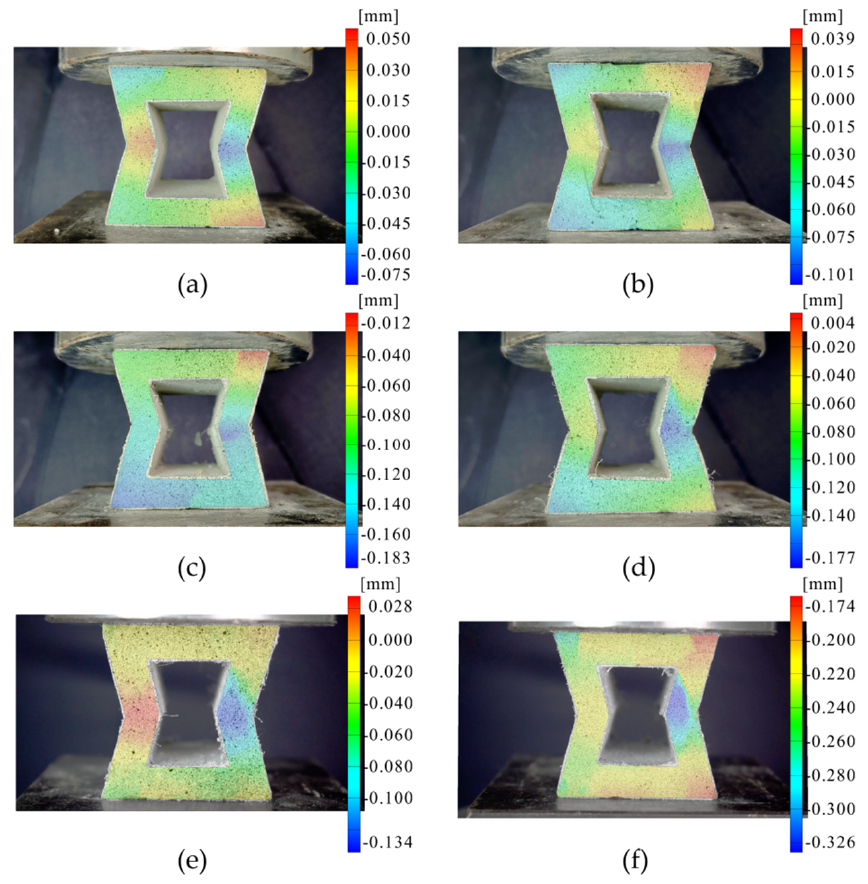
Figure 4. Cloud diagram of lateral displacement of the concave hexagonal unit cell: ( a ) A−0; ( b ) A−0.5; ( c ) A−1.0; ( d ) A−1.5; ( e ) A−2.0; ( f ) A−2.5.